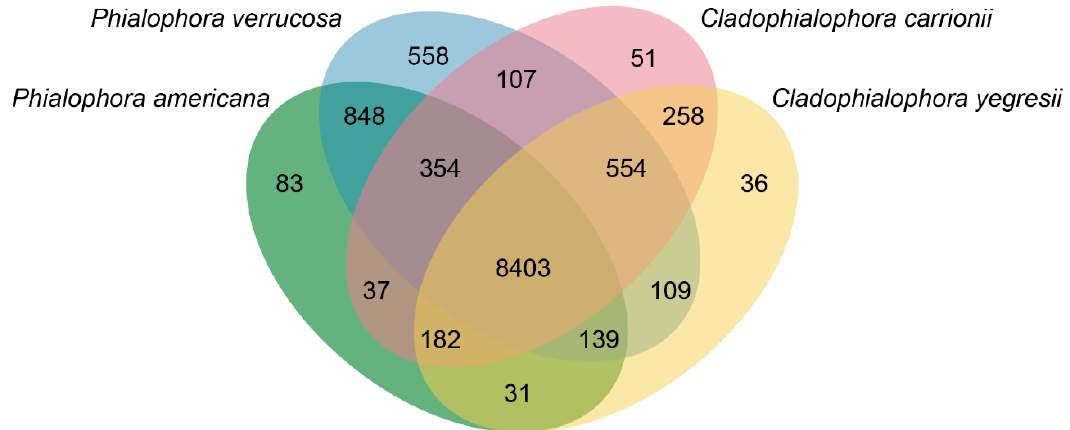
Figure 6. Whole-genome comparison of Phialophora verrucosa and P. americana with Cladophialophora carrionii and C. yegresii ; all species are members of the carrionii-clade in Chaetothyriales . C. yegresii represents a non-clinical species, while P. verrucosa and C. carrionii are clinical. Numbers in the Venn diagram are the unique and shared genes among the species.